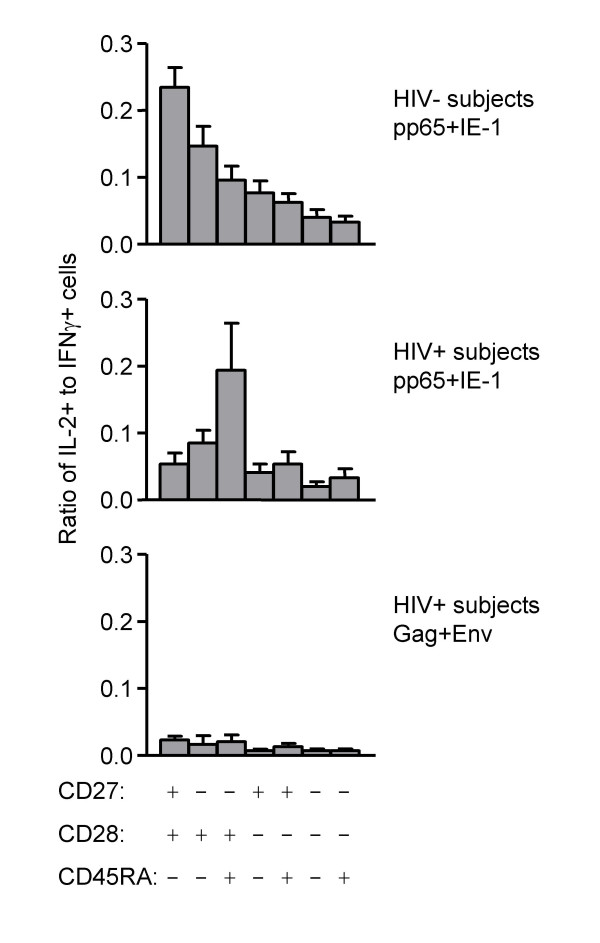
Production of IL-2 by various phenotypes of CD8+ T cells. Each bar represents the mean (for 20 HIV-negative or 19 HIV-positive subjects) of the ratios of IL-2 to IFNγ production for each of the phenotypes, as listed at the bottom of the figure. Phenotypes are arranged by amount of IL-2 production; naïve cells (CD27+ CD28+ CD45RA+) were not analyzed as they are not expected to make IFNγ. Error bars represent SEM. Results are shown for the response of HIV-negative subjects to pp65+IE-1 stimulation (top), the response of HIV-positive subjects to pp65+IE-1 stimulation (middle), and the response of HIV-positive subjects to Gag+Env stimulation (bottom).